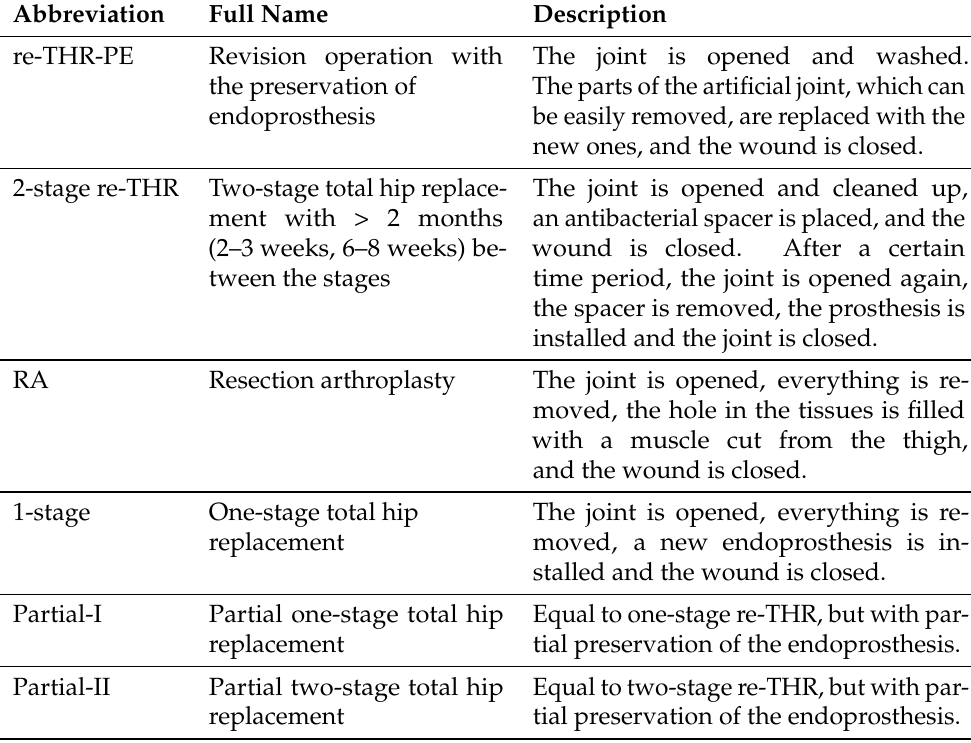
Table 2. Description of treatment methods.